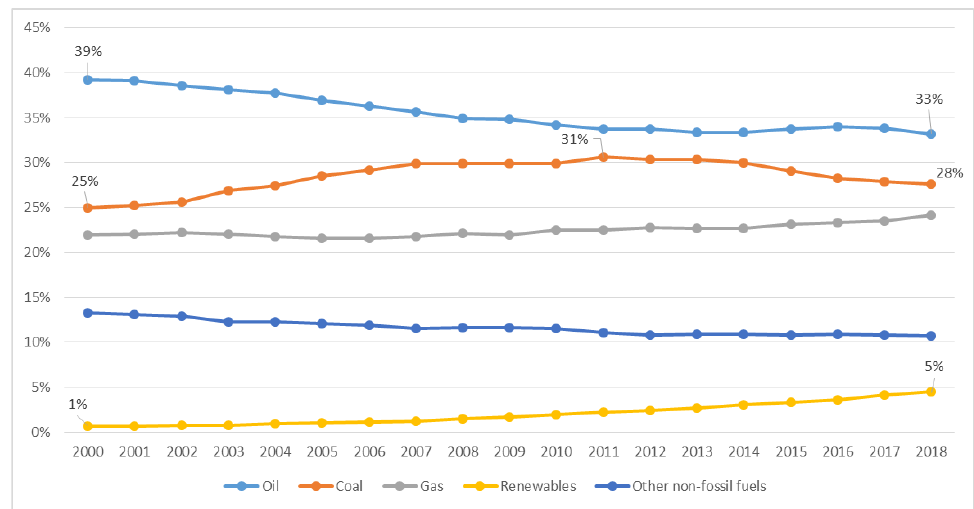
Energies 2022 , 15 , x FOR PEER REVIEW Figure 1. Global shares of primary energy 2000 – 2018. Source: BP. Figure 1. Global shares of primary energy 2000–2018. Source: BP.